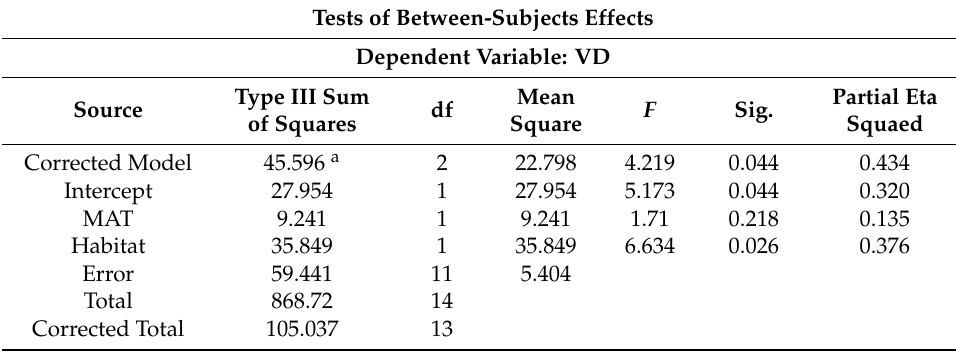
Table A3. The result of ANCOVA between vein density (VD) and MAT in hillside and valley habitats.